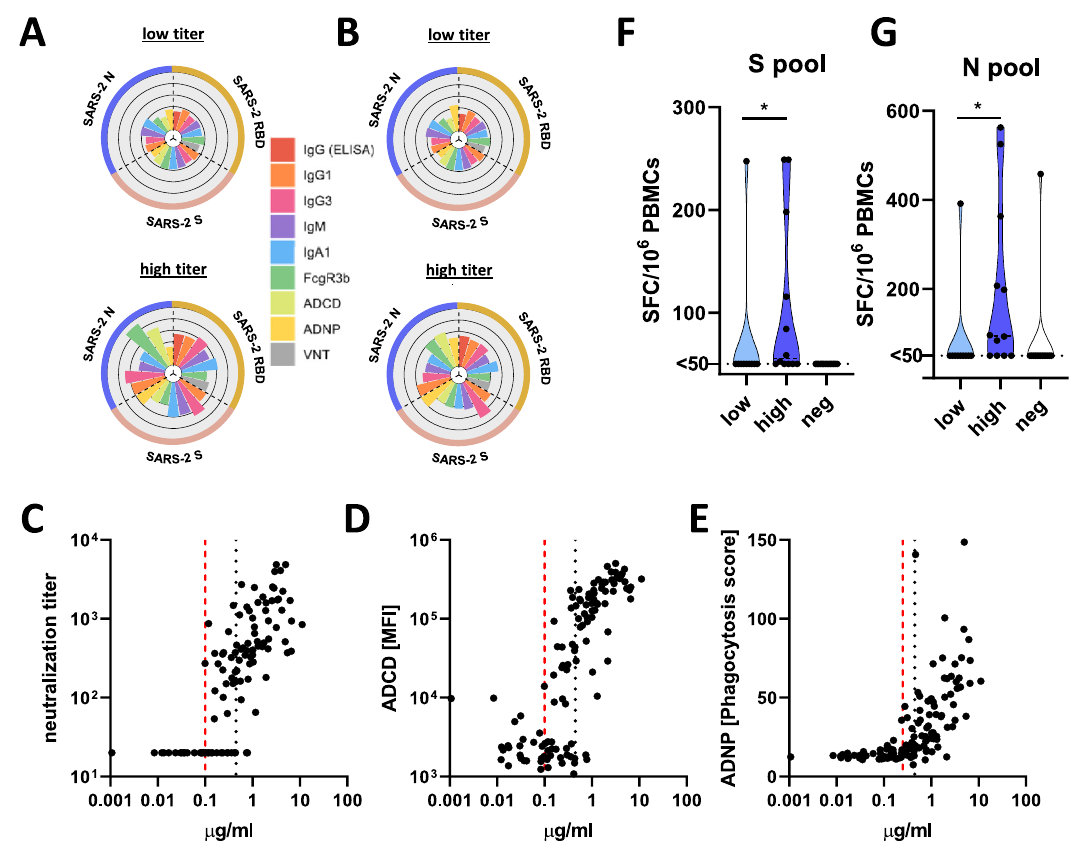
Fig. 4 A discrete titer cut-off tracks with functional SARS-CoV-2 humoral and T cell immunity. A , B The fl ower plots summarize titer and functional data against SARS-CoV-2 RBD, S or N antigen in high or low titer group at maximum observed titers ( A ) and the following timepoint ( B ) (the petal color corresponds to features as indicated; the univariate data are also shown in Fig. 3 and Supplementary Fig. 2). C – E Antibody-dependent virus neutralization ( C ), ADCD ( D ) or ADNP ( E ) by ELISA RBD titer. The black dotted line indicates the median split (0.45 μ g/ml) and the red dashed line the threshold titer for the individual functions. F , G The violin plots show the number of spots forming cells (SFC) of interferon-gamma (IFN γ ) secreting T cells after overnight stimulation with either an overlapping peptide pool covering SARS-CoV-2 S ( F ) or N ( G ) in individuals with low titers (light blue, n = 10), high titers (dark blue, n = 12) or negative controls (white, n = 14). Statistical differences between two groups were assessed with a two-sided non-parametric Mann – Whitney test (in ( F ) *: p = 0.039, in ( G ) *: p = 0.018). Source data are provided as a Source Data fi